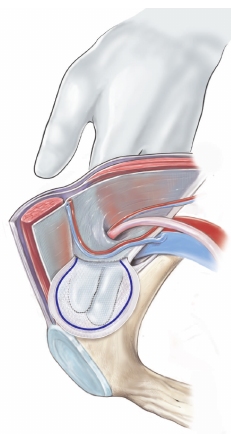
Figure 12: The mesh is placed medially in the preperitoneal space.